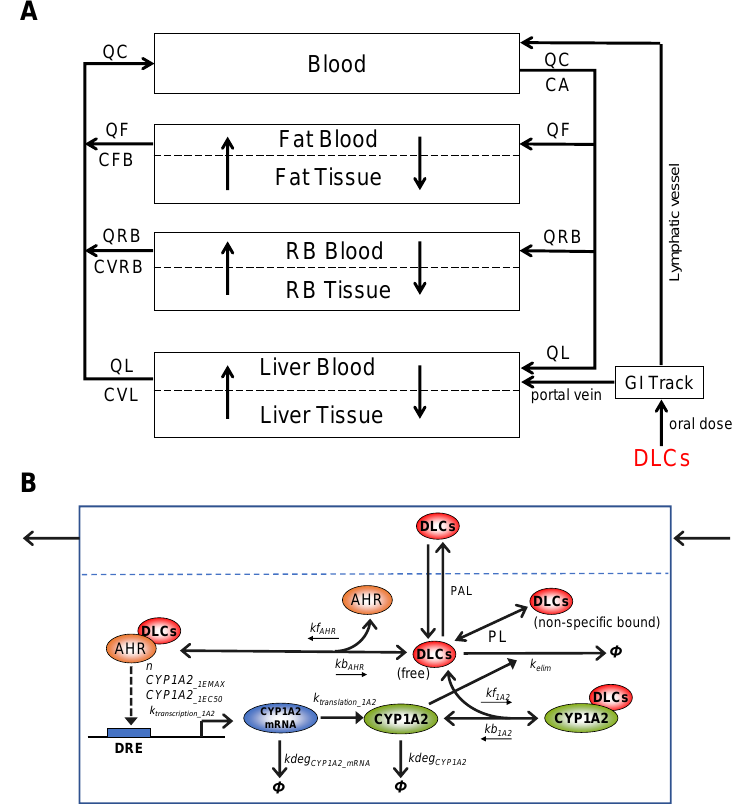
Figure 1. Schematic illustration of the structure and molecular key events of the DLC mixture PBPK model. ( A ) The overall structure of the DLC mixture PBPK model containing four blood circulation-connected compartments: Blood , Fat , RB , and Liver . The latter three are further divided into blood and tissue subcompartments to account for diffusion-limited distribution processes. ( B ) Details of the molecular key events in Liver Tissue : Competitive, reversible binding of DLCs for AHR